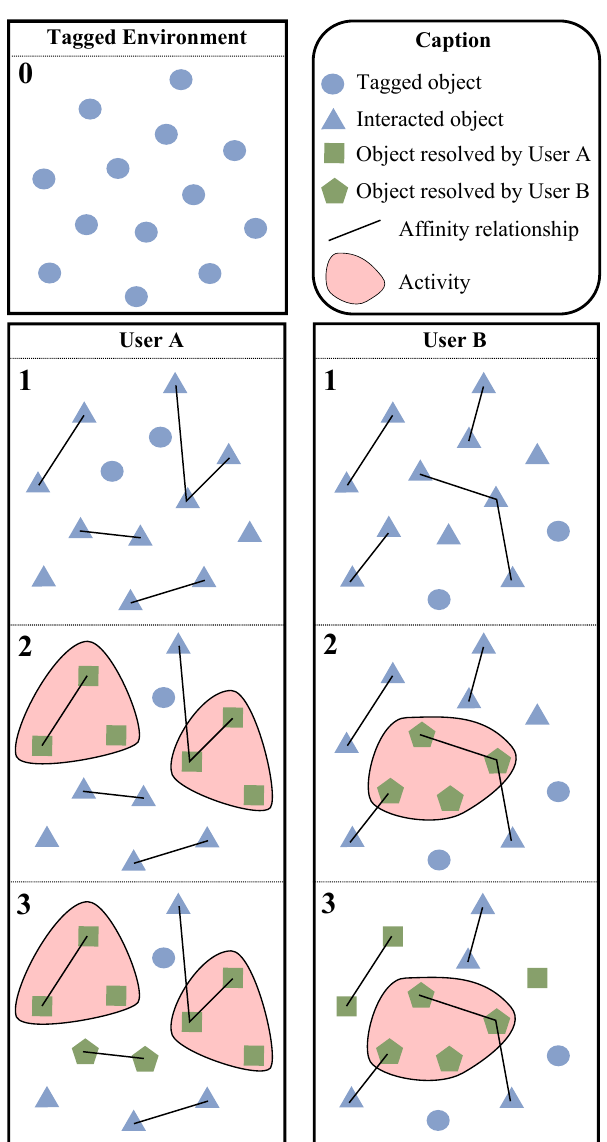
Figure 6. Tag sharing process